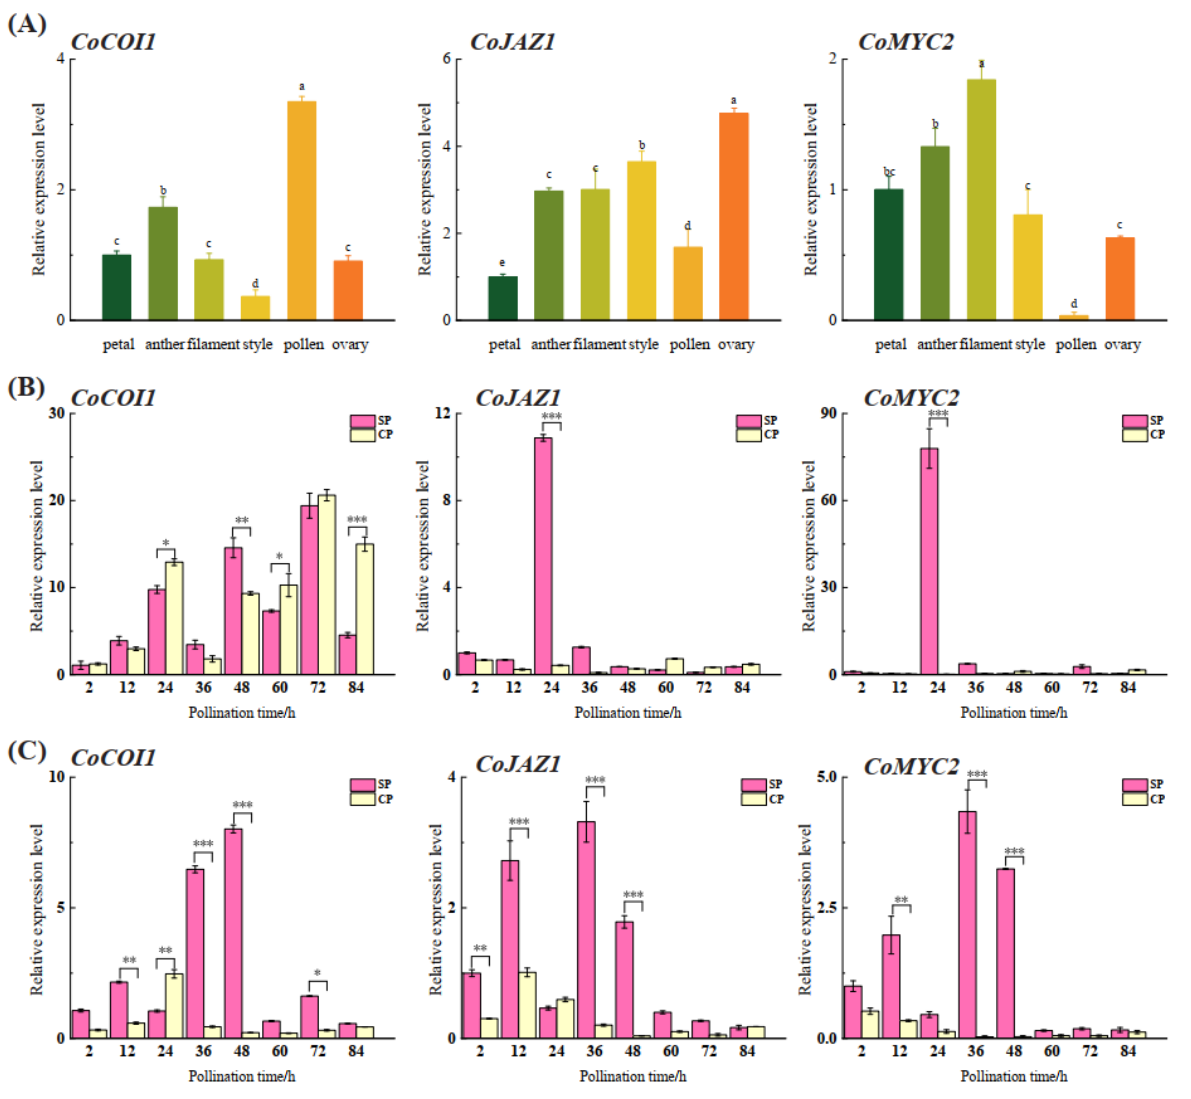
Figure 4. Expression levels of CoCOI1 , CoJAZ1 , and CoMYC2 . ( A ) Expression levels of CoCOI1 , CoJAZ1 , and CoMYC2 in different tissues. The expression levels were measured by qRT ‐ PCR and standardized by CoGAPDH . Lowercase letters represent significant differences in the expression levels in various tissues ( p < 0.05). Error bars show±SD. ( B ) Expression levels of CoCOI1 , CoJAZ1 , and CoMYC2 in self ‐ or cross ‐ pollinated styles. The transcript levels were measured by qRT ‐ PCR and standardized by CoGAPDH . The asterisks represent significant differences in expression levels (Student’s t ‐ test): * p < 0.05; ** p < 0.01; *** p < 0.001. Error bars show ± SD. ( C ) Expression levels of